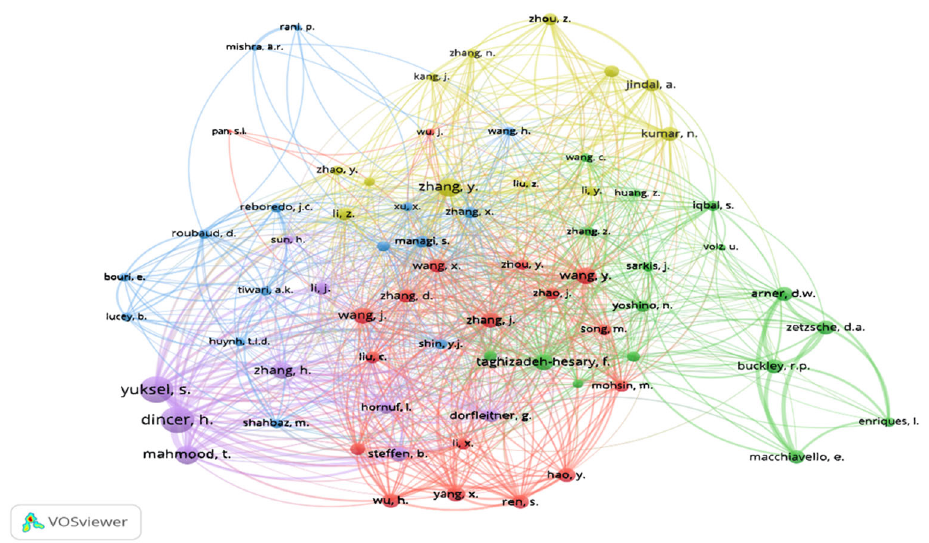
Figure 10. Bibliometric coupling of author analysis.